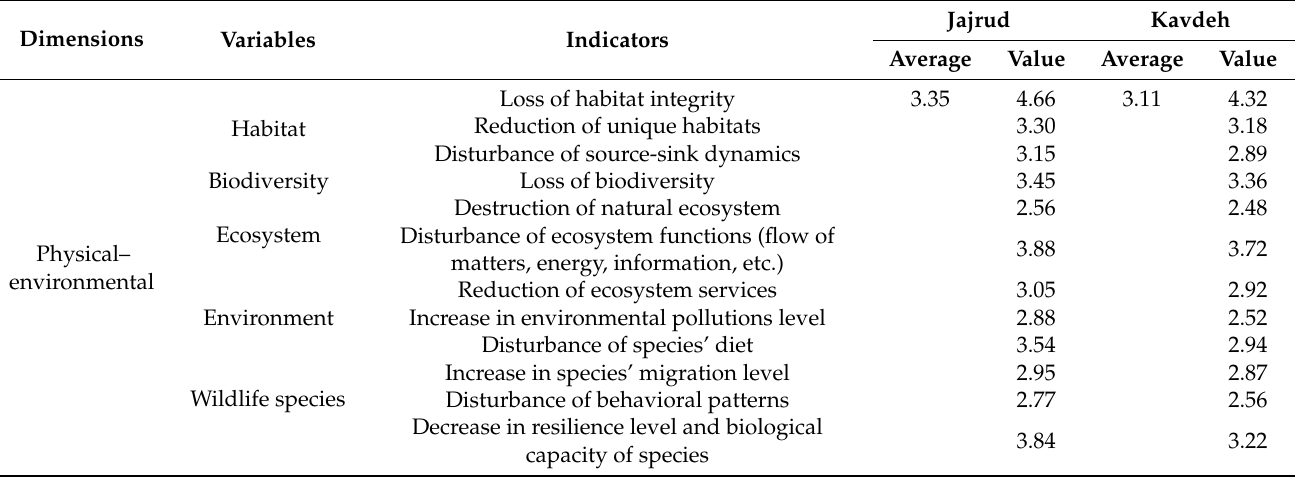
Table 10. Average and values of expert ratings (1 = lowest, 5 = highest) to assess the extent to which indicators are affected by ecological risk in two Protected Areas in the Tehran province,